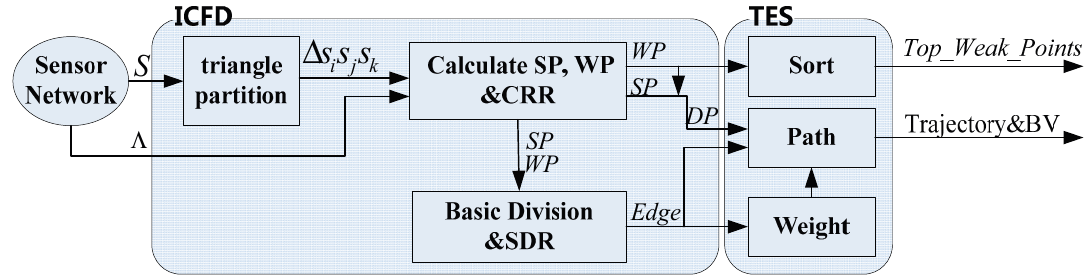
Figure 5. The in-out correlation between the ICFD and the